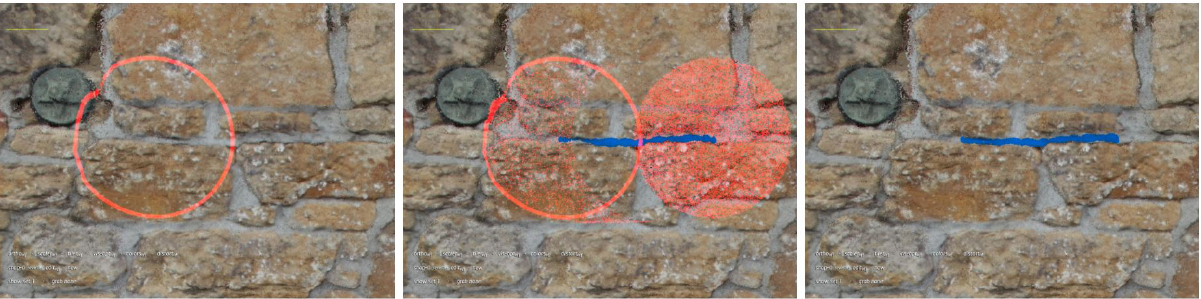
Figure 2. Example of the interactive annotation used on dense point cloud